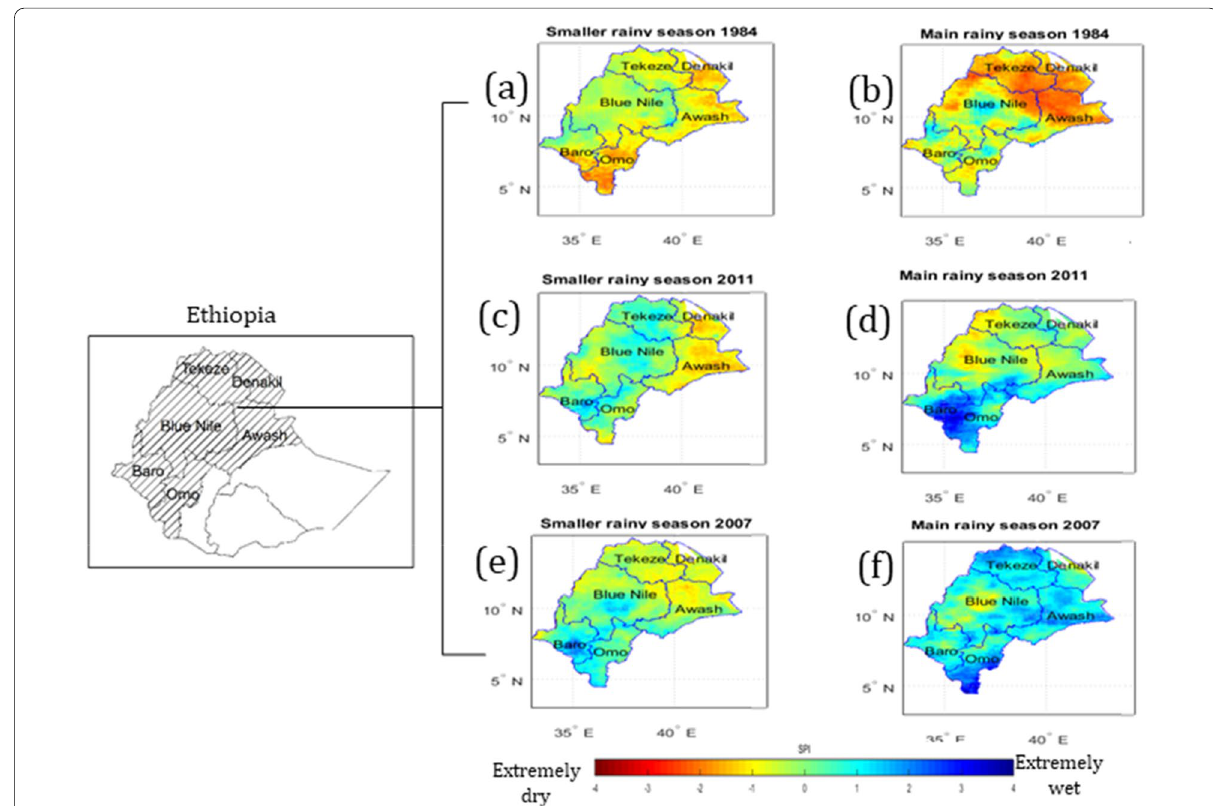
Fig. 9 Spatial pattern of seasonal SPI values in the selected river basins in 1984 and 2011 drought years and 2007 (drought-free year) during the smaller rainy season ( a , c and e ) and main rainy season ( b , d and f